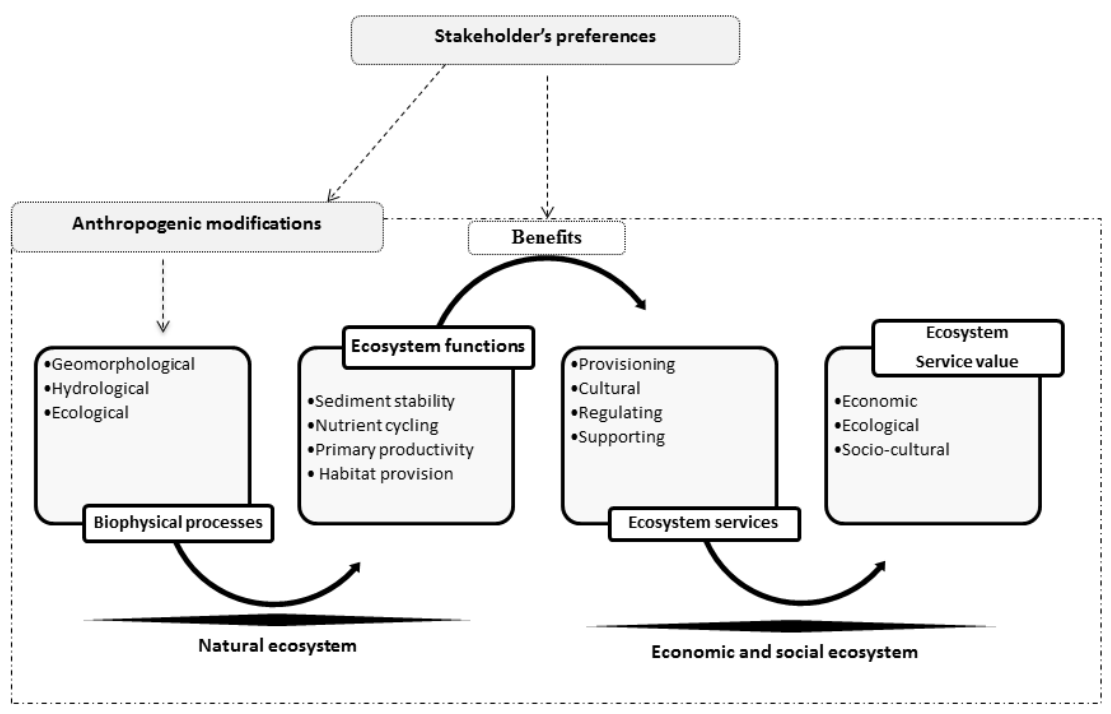
Figure 1. An overview of anthropogenic modifications on river ecosystem services (ESs).